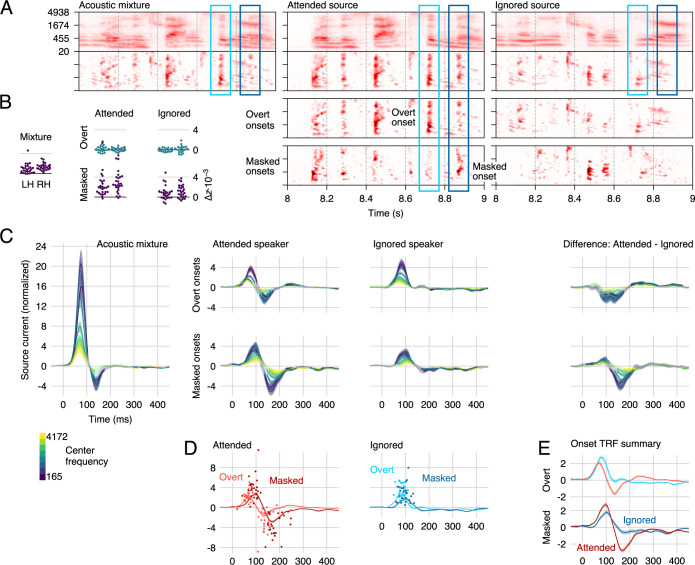
Responses to overt and masked onsets.(A) Spectrograms (note that in this Fig, the onset representations are placed below the envelope representations, to aid visual comparison of the different onset representations) were transformed using element-wise operations to distinguish between overt onsets, i.e., onsets in a source that are apparent in the mixture, and masked onsets, i.e., onsets in a source that are masked in the presence of the other source. Two examples are marked by rectangles: The light blue rectangle marks a region with an overt (attended) onset, i.e., an onset in the attended source that also corresponds to an onset in the mixture. The dark blue rectangle marks a masked (attended) onset, i.e., an onset in the attended source which is not apparent in the mixture. (B) All predictors significantly improve the cross-validated model fit (note that improvements were statistically tested with a test sensitive to spatial variation, whereas these plots show single-subject ROI average fits). (C) The corresponding overt/masked STRFs exhibit the previously described positive–negative 2-peaked structure. The first, positive peak is dominated by a representation of the mixture but also contains segregated features of the 2 talkers. For overt onsets, only the second, negative peak is modulated by attention. For masked onsets, even the first peak exhibits a small degree of attentional modulation. (D) Responses to masked onsets are consistently delayed compared with responses to overt onsets. Details are analogous to Fig 3D, except that the time window for finding peaks was extended to 20–250 milliseconds to account for the longer latency of masked onset response functions. (E) Direct comparison of the frequency-averaged onset TRFs highlights the amplitude differences between the peaks. For overt onsets, the negative deflection due to selective attention starts decreasing the response magnitude even near the maximum of the first, positive peak. For masked onsets, the early peak reflecting attended onsets is increased despite the subsequent enhanced negative peak. Results for envelope predictors are omitted from this figure because they are practically indistinguishable from those in Fig 3. Data are available in S3 Data. LH, left hemisphere; RH, right hemisphere; ROI, region of interest; STRF, spectrotemporal response function; TRF, temporal response function.